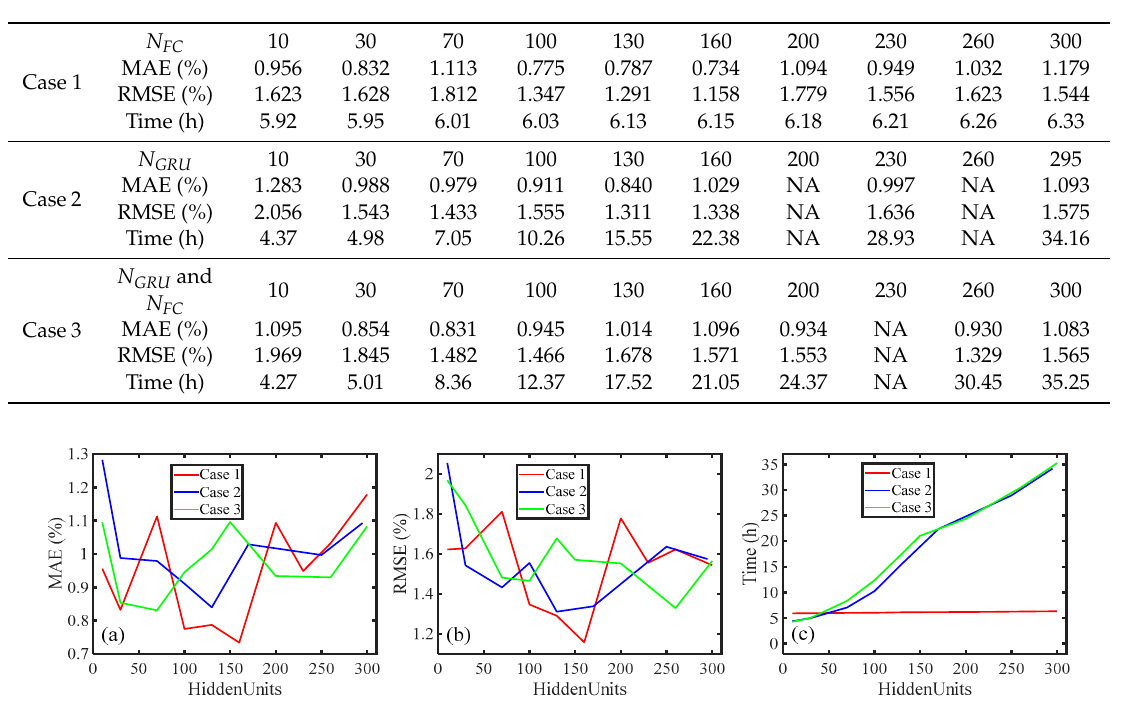
Table 5. SOC error results of case 1 ( N GRU = 55, N FC = 160).